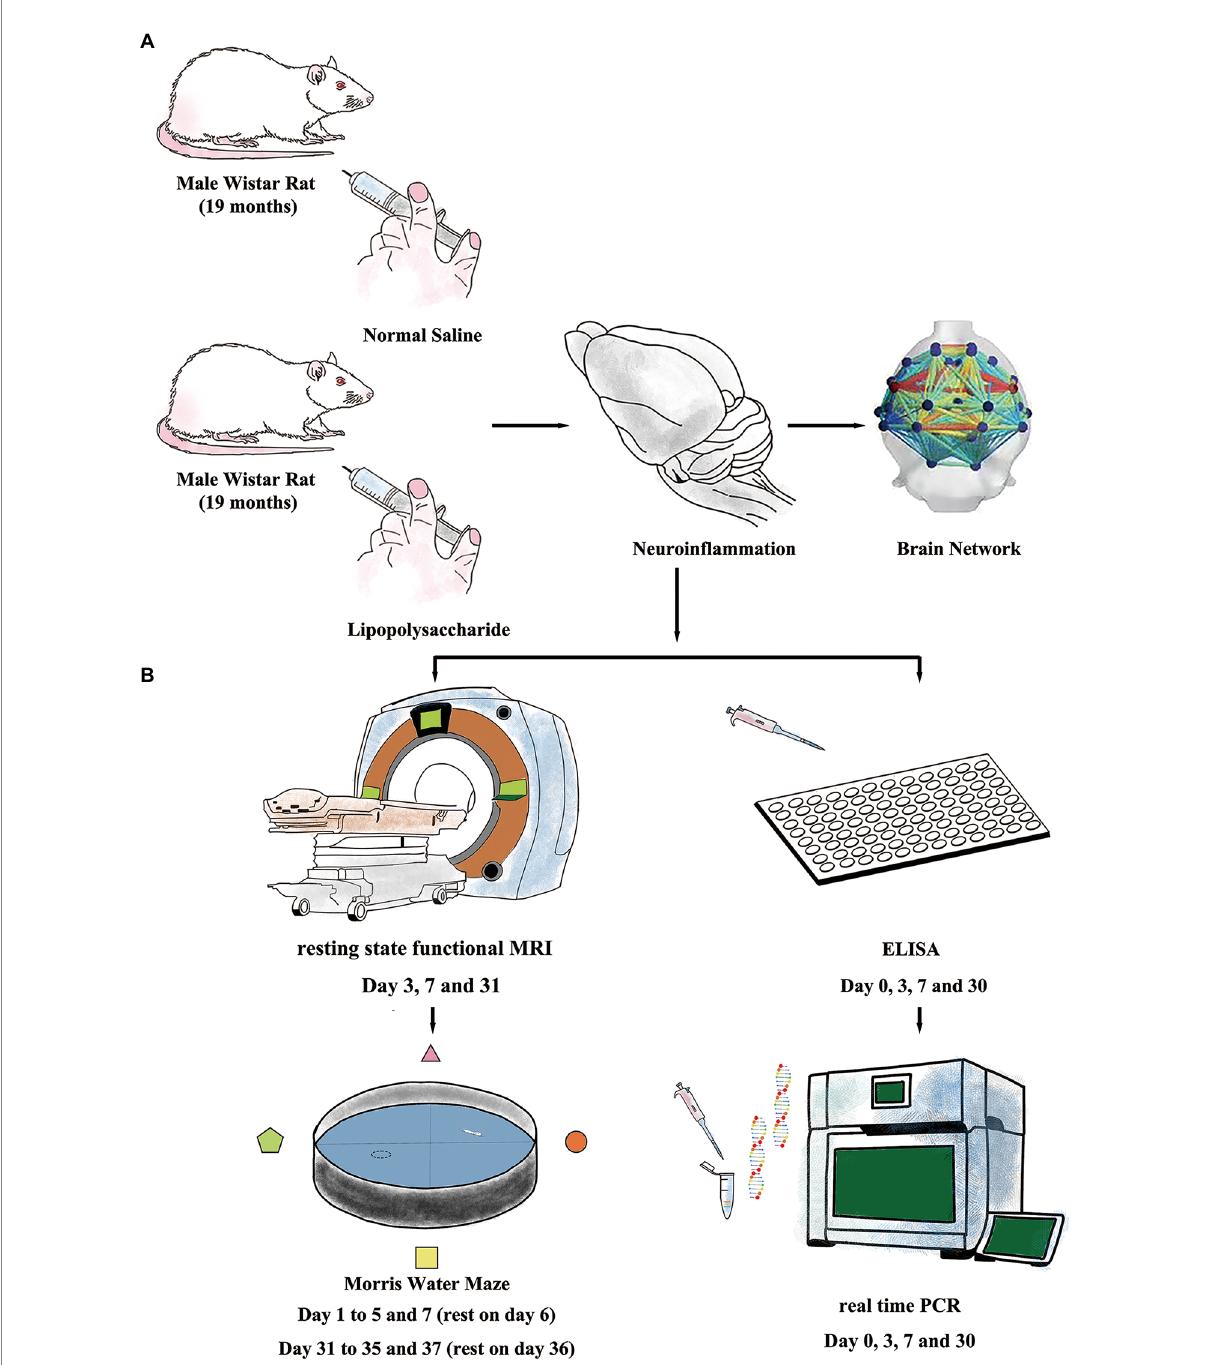
FIGURE 1 Experiment protocols. (A) Inflammatory exposure was induced by intraperitoneal injection of lipopolysaccharide (LPS, 2 mg/kg) in aged rat. The LPS further induced short- and long-term neuroinflammation and resulted in impaired brain network. (B) Resting-state-functional magnetic resonance imaging (rs-fMRI) and Morris Water Maze (MWM) were used to evaluate changes in neural network and cognitive function. Enzyme- linked immunosorbent assay (ELISA) and real-time polymerase chain reaction (RT-PCR) were performed to study